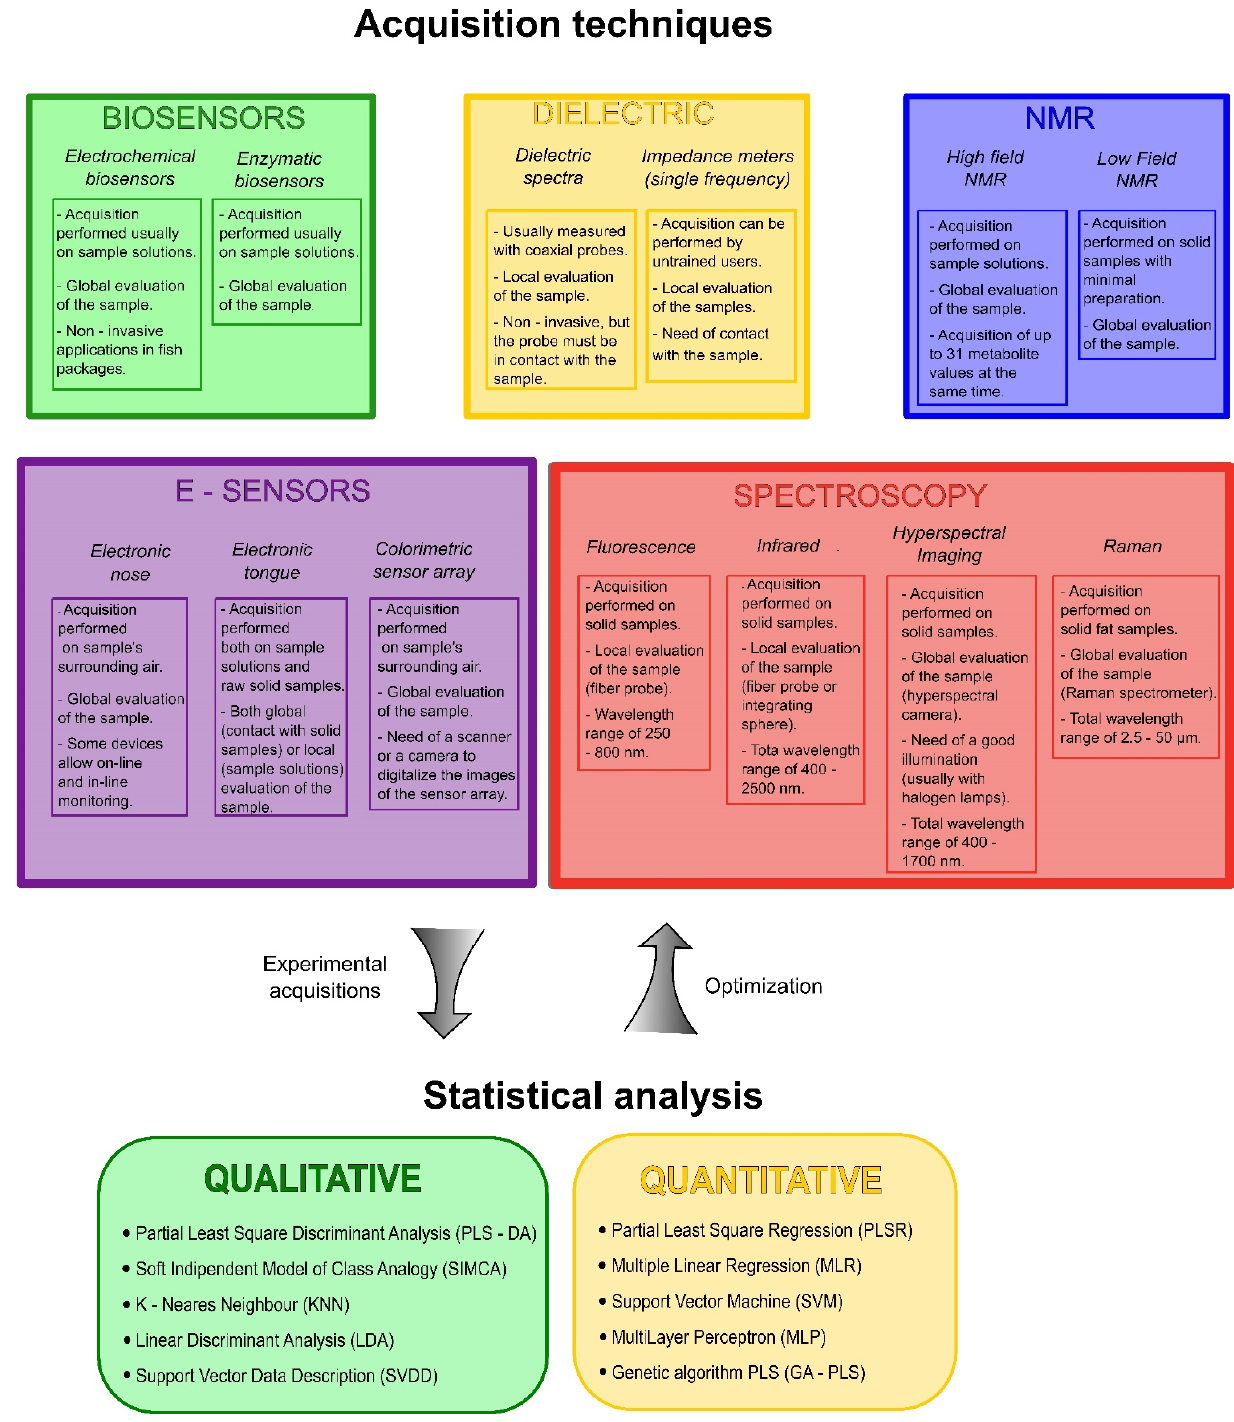
Figure 1. Summary scheme of the indirect acquisition techniques reported in the paper (on the left) and of the different statistical algorithms used for the creation of a calibration model (on the right).